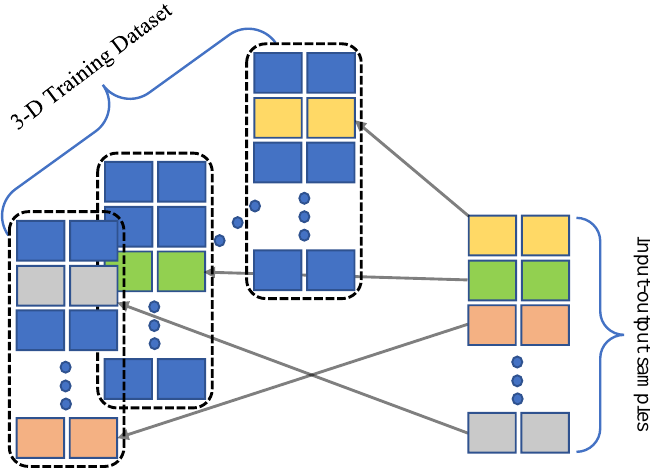
Figure 4. Proposed dataset compilation